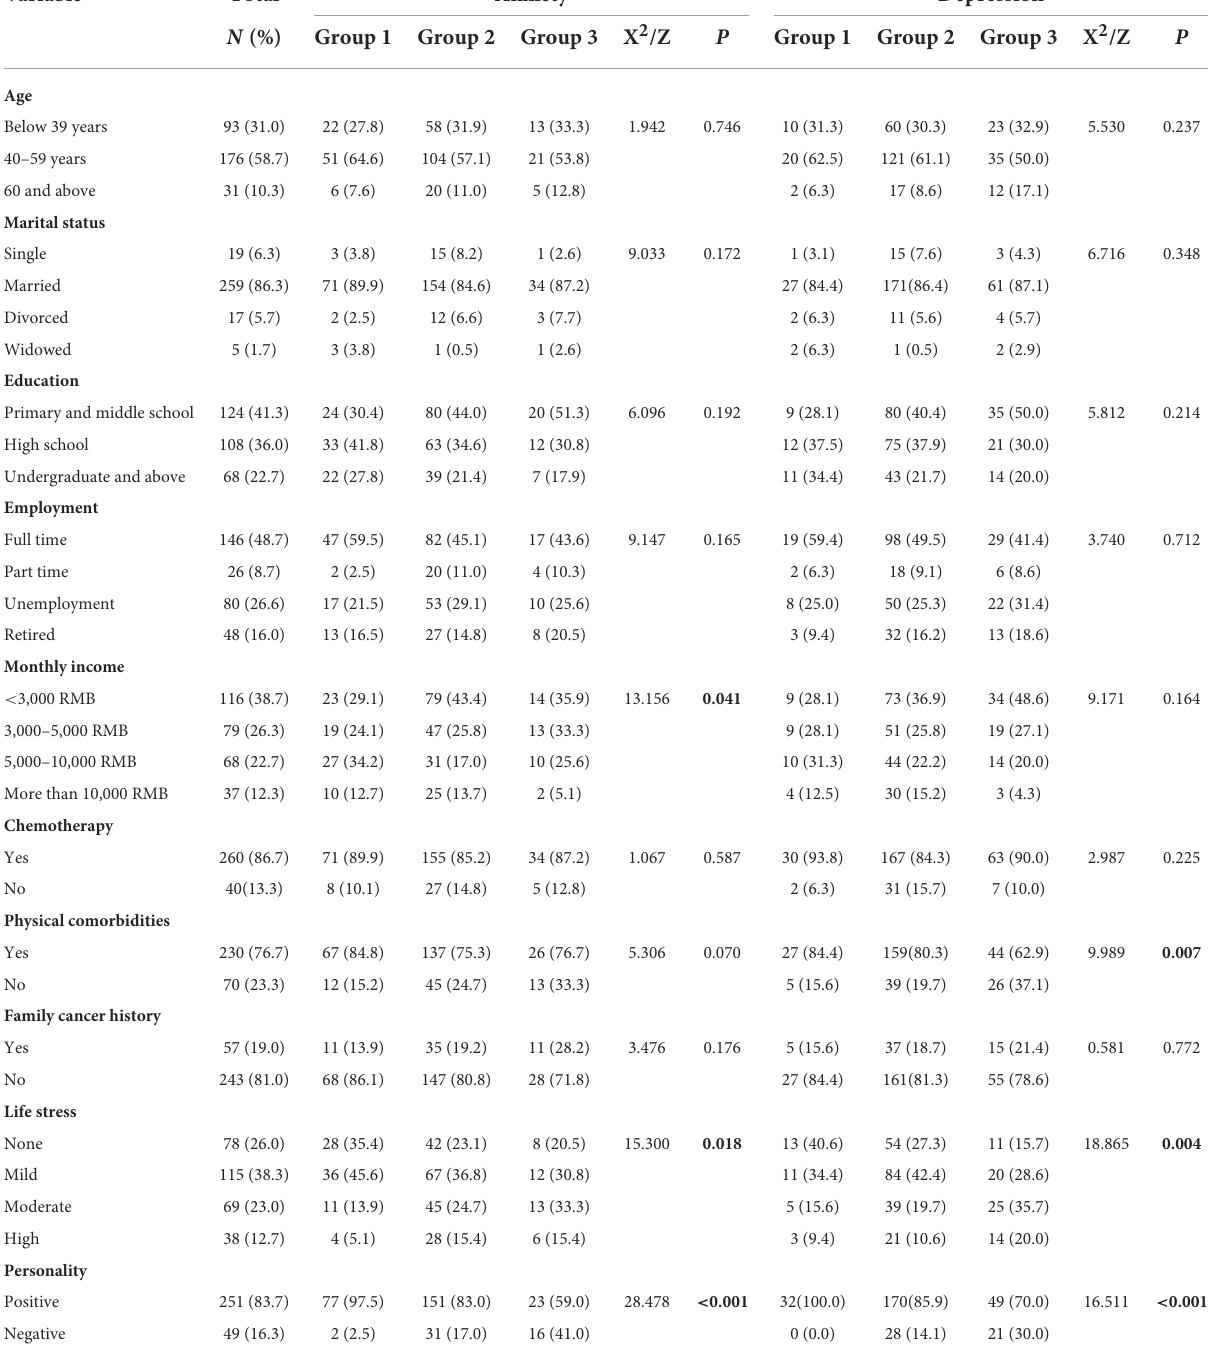
TABLE 1 Demographic and clinical characteristics of participants among different trajectory groups ( N =